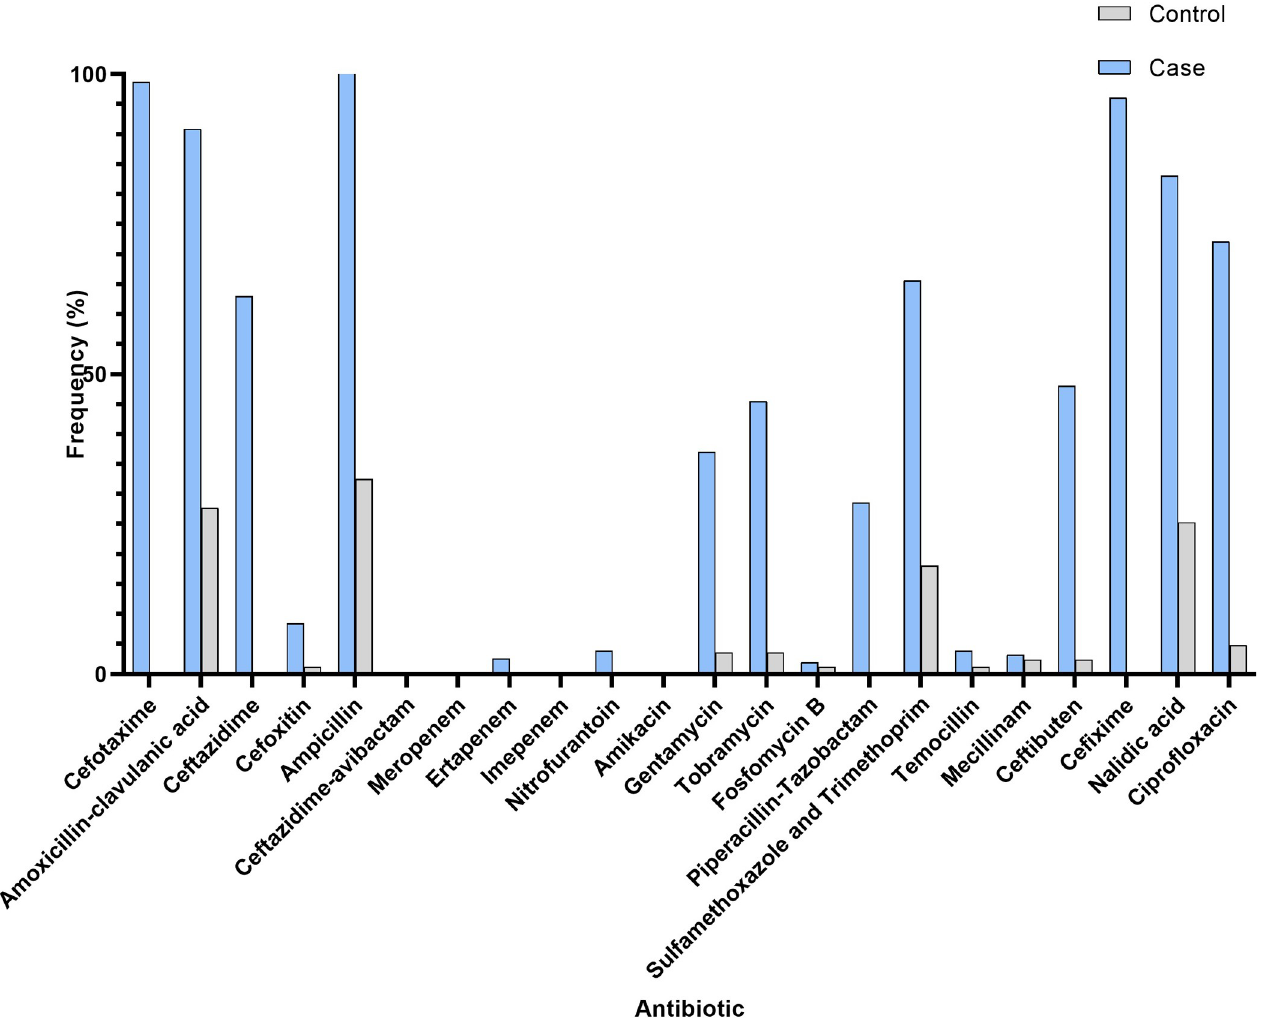
Fig 2. Antibiotic resistance levels, ESBL-UPEC (case) isolated from blood and urine were matched 1:1 with non-ESBL UPEC (control) for age, gender and year of culture 2009–2018 in southeast of Sweden. Bars represent frequency of isolates with zone diameters corresponding to resistant or area of technical uncertainty according to EUCAST